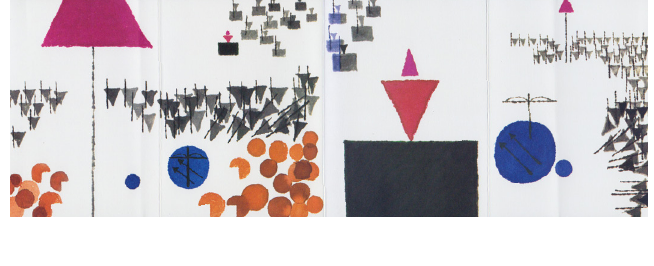
Fig. 10 Warja Lavater, Gessler proposes the challenge of the apple ; Tell nocks the arrow ; Tell centers the apple and shows the second arrow . Warja Lavater (1962). Wilhelm Tell. Basel: Basilius Presse.